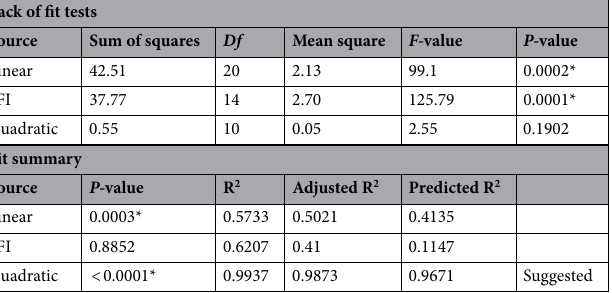
Table 3. Fit summary for Box–Behnken design results for chitosan nanoparticles biosynthesis using Eucalyptus globulus Labill leaves extract as affected by chitosan concentration (%), initial pH level, temperature (°C) and incubation period (min). df degree of freedom, 2FI two factors interaction. *Significant